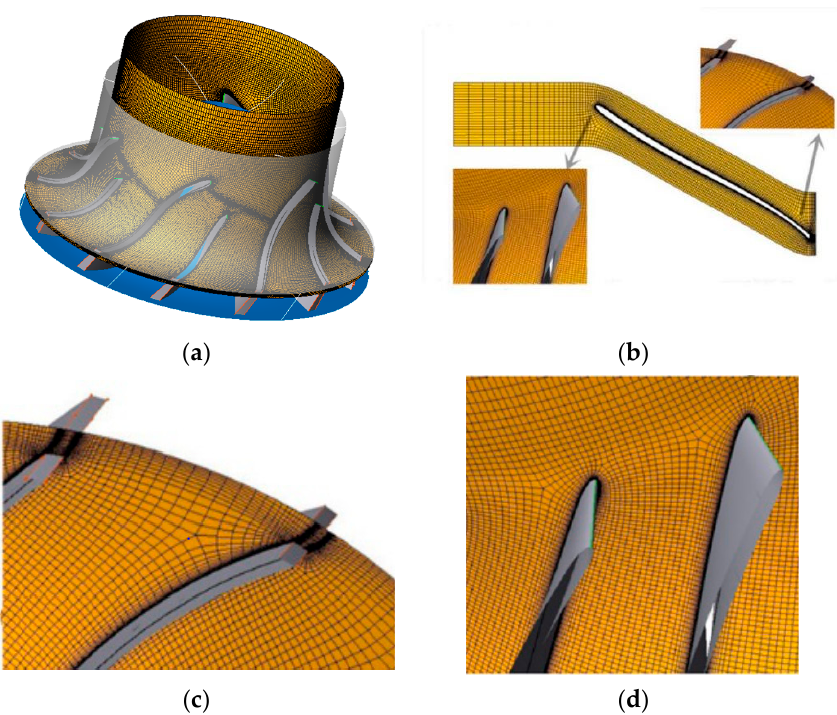
Figure 2. Grid of the centrifugal impeller and single channel: ( a ) grid of the centrifugal impeller, ( b ) grid of a single channel, ( c ) grid of a partial single channel, ( d ) grid of a partial single channel.